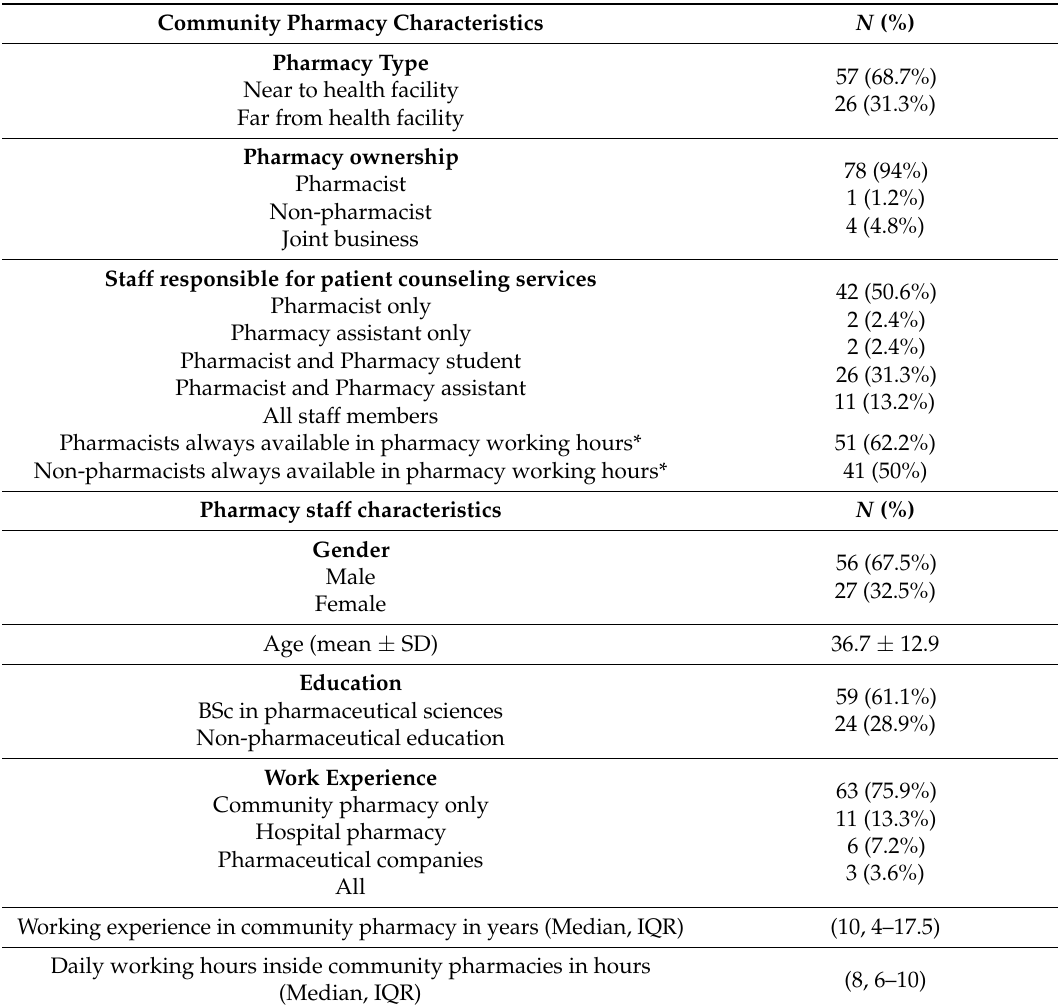
Table 3. Pharmacy characteristics and pharmacy staff characteristics from interview data, N = 83.